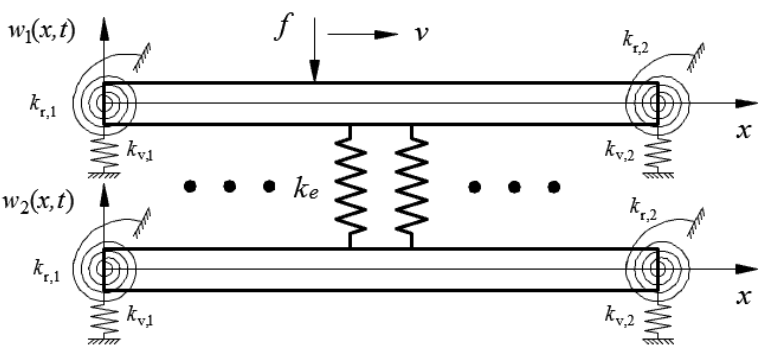
Figure 10. Mode amplitude ratios in two sub-modes corresponding to the 1st basic mode versus beam stiffness ratio for different boundary conditions when 𝑠 e = 100 and 𝑠 m = 1 .